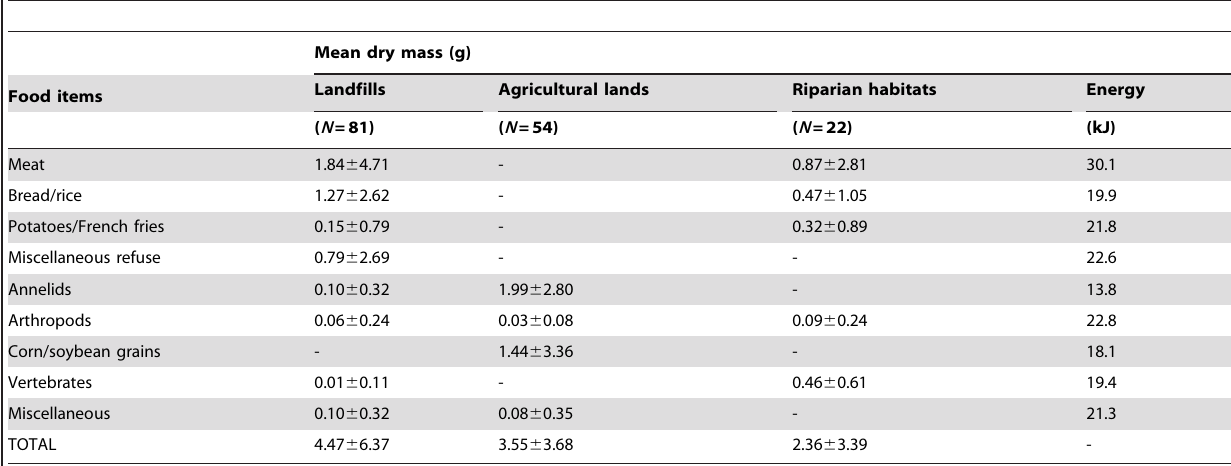
Table 4. Mean dry mass (g 6 SD) and mean energy value (kJ) of nine food items gathered by sub-adult and adult Ring-billed Gulls in three habitat types ( N =number of birds with food items present in their